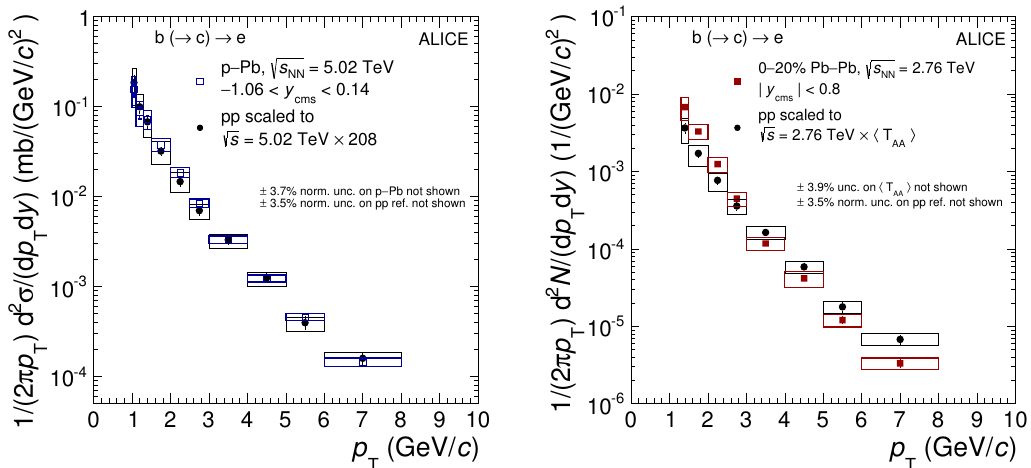
Figure 5 . Invariant cross section (left) and yield (right) of electrons from beauty-hadron decays p as a function of transverse momentum in minimum-bias p-Pb collisions at s NN = 5.02 TeV and in p the 20% most central Pb-Pb collisions at s NN = 2.76 TeV. The pp reference spectra scaled by the number of nucleons in the Pb nucleus (A = 208) and by h T AA i , respectively, are shown as well. The vertical bars represent the statistical uncertainties, the boxes indicate the systematic